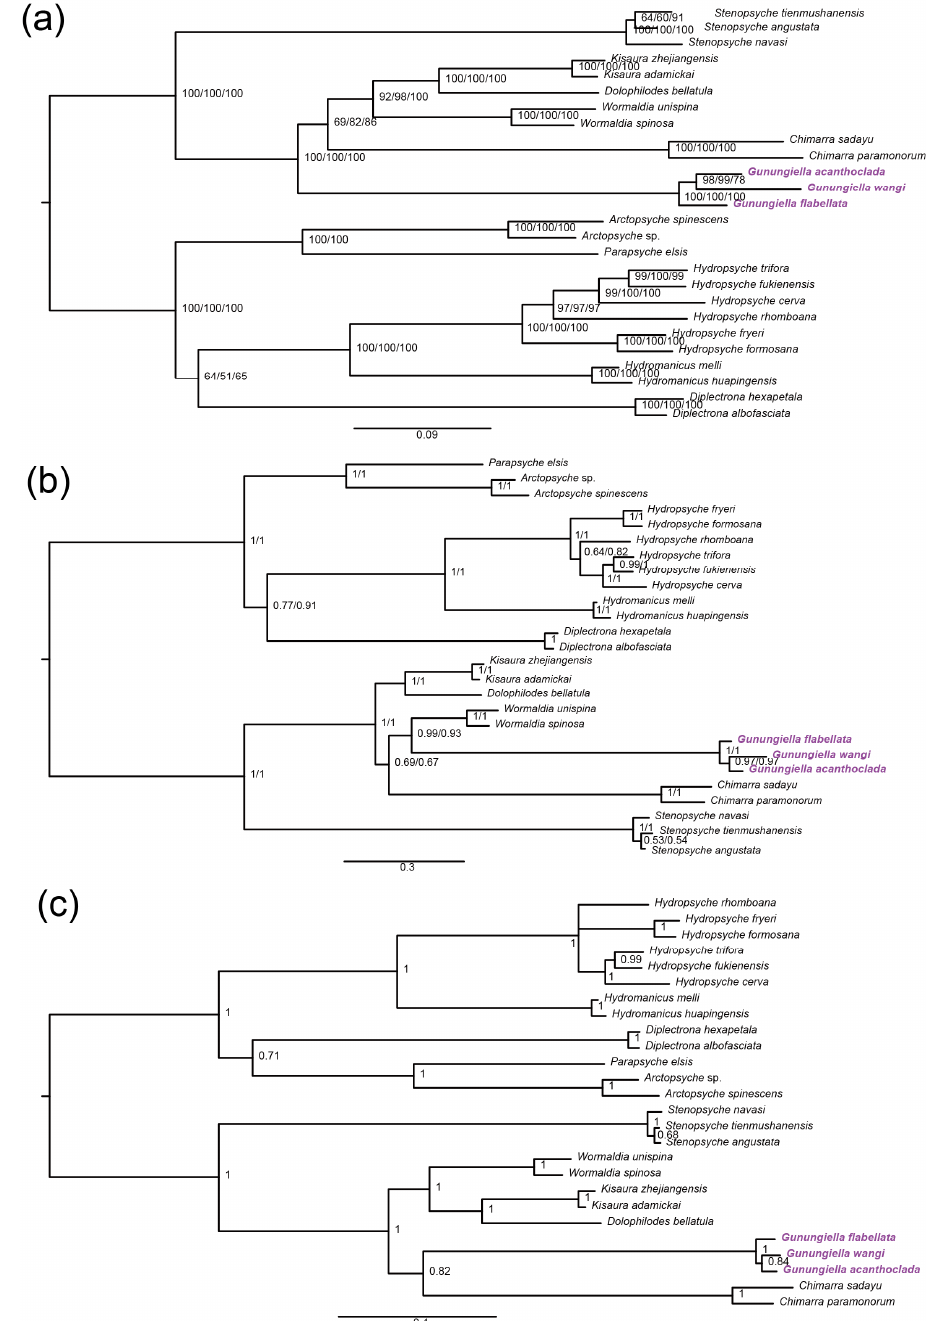
Figure 6. Phylogeny of Philopotamidae as inferred from analyses of the three datasets under the ML model and CAT + GTR mixture model. ( a ) ML tree based on the analysis of three datasets with a partitioning model in IQ-TREE. Node values represent bootstrap probabilities of PCG12, PCG12R and PCGFAA datasets, respectively. ( b ) Phylogeny of Philopotamidae based on PCG12R and PCG12 dataset using CAT+GTR model in phylobayes. Node supports are Bayesian posterior probabilities of PCG12R and PCG12 datasets, respectively. ( c ) Phylogeny of Philopotamidae based on PCGFAA dataset using CAT+GTR model in phylobayes. Node supports are Bayesian posterior probabilities.